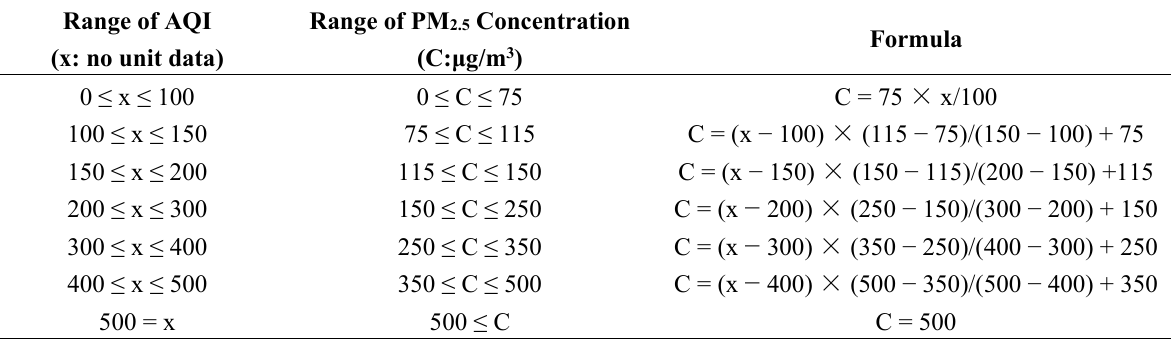
Table 1. Deriving the PM 2.5 concentration from the